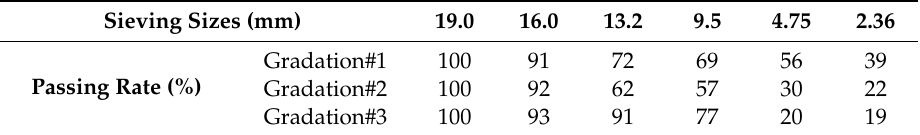
Table 3. Passing rates of three gradations for static pressure test.